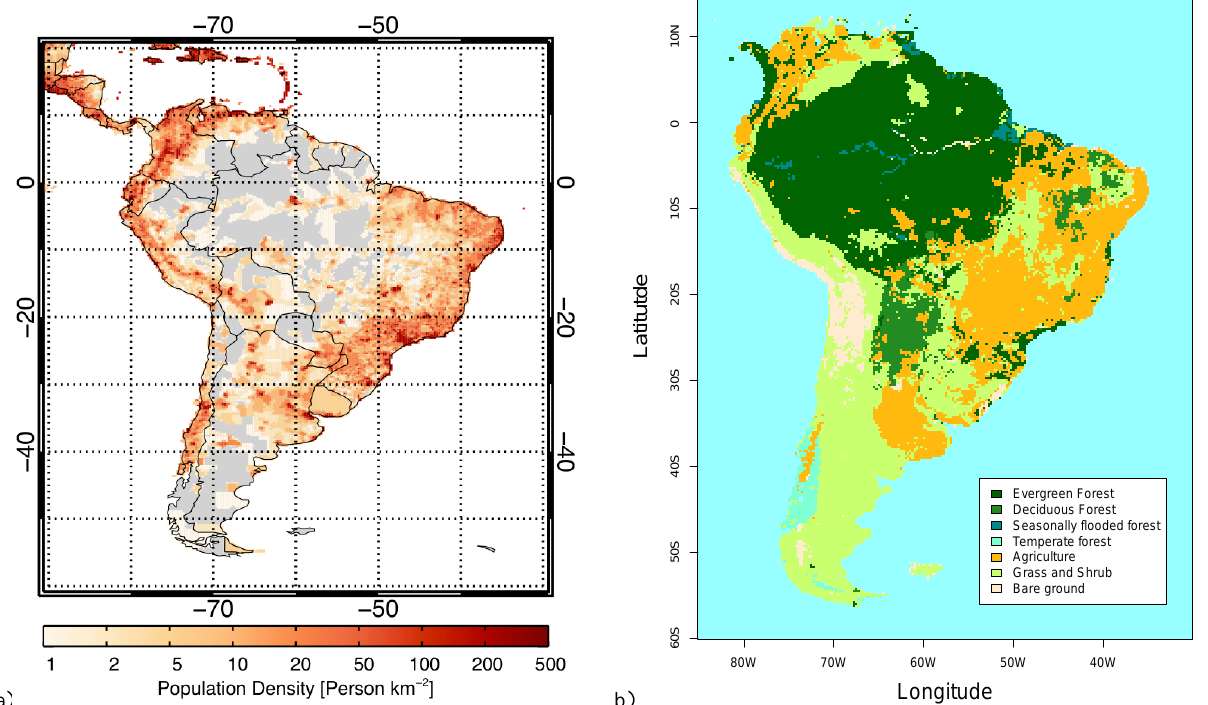
Fig. 1. (a) Population density in South America in the year 2005 (CIESIN, 2005), and (b) land cover map of South America for 1995–2000 derived from remote sensing by Eva et al. (2004).